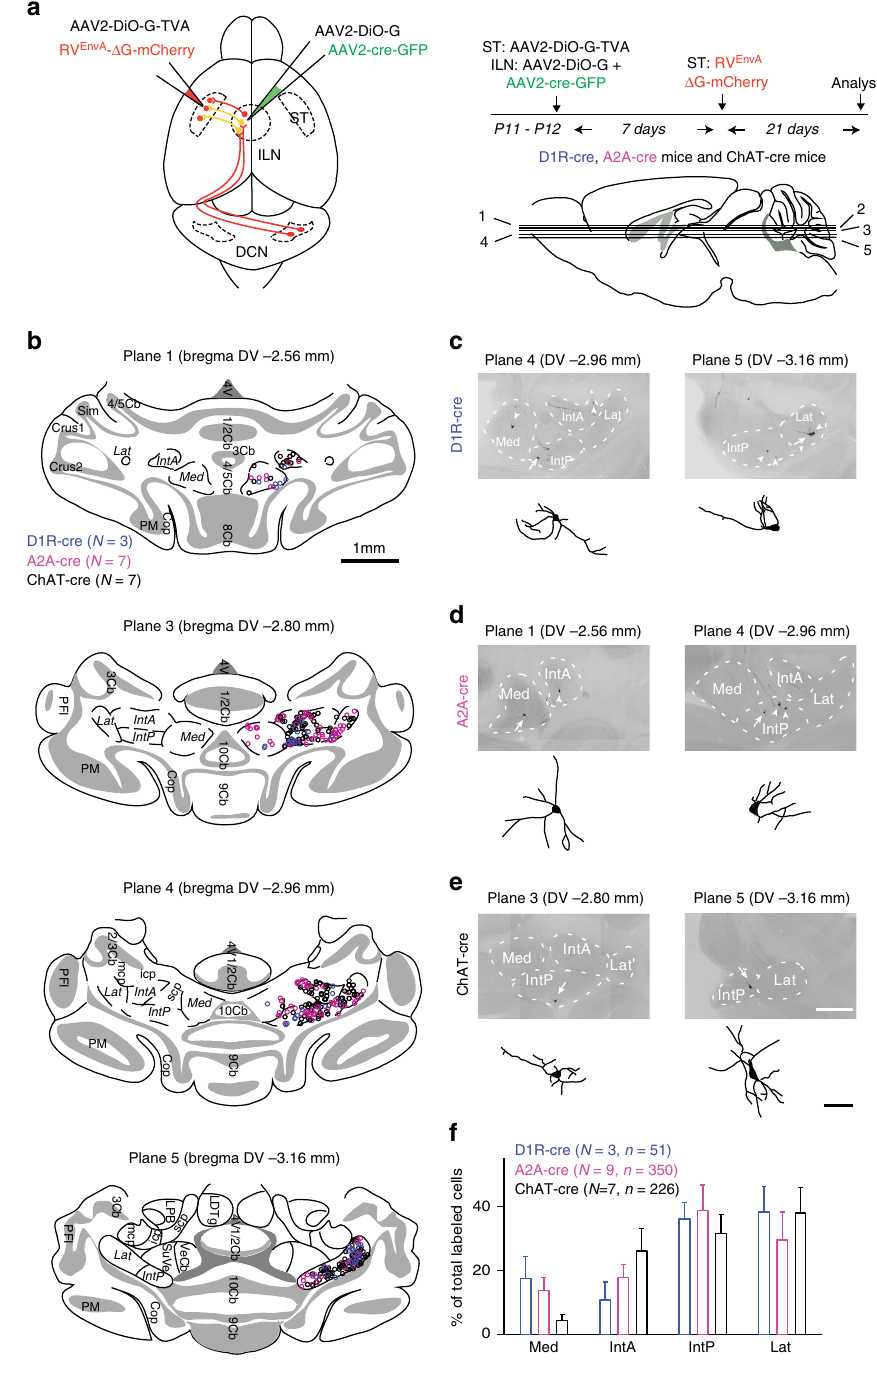
medial cerebellar nucleus at postnatal day 18 (AAV2-DiO-hM4Di x vGluT2cre: DCN:vGluT2 hM4Di , Fig. 6a, b). Location and number of hM4Di-expressing cells was con fi rmed by immuno- histochemistry. Viral expression reliably targeted the interposed and medial cerebellar nuclei and was only rarely detected in the lateral (dentate) deep cerebellar nucleus (Fig. 6b). Only mice with >50% IntP neurons expressing hM4Di-mCherry were included in quanti fi cations of behavioral performance across all tasks